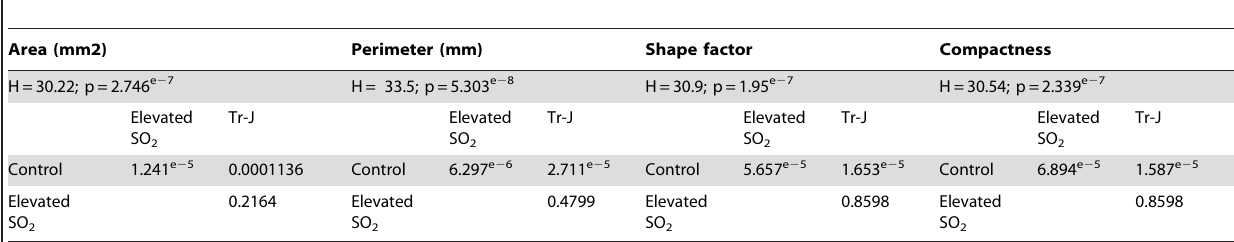
Table 5. Kruskal Wallis and Mann-Whitney pair-wise comparisons for each physiognomic trait in Ginkgo biloba in the different simulated palaeoatmospheric treatments.